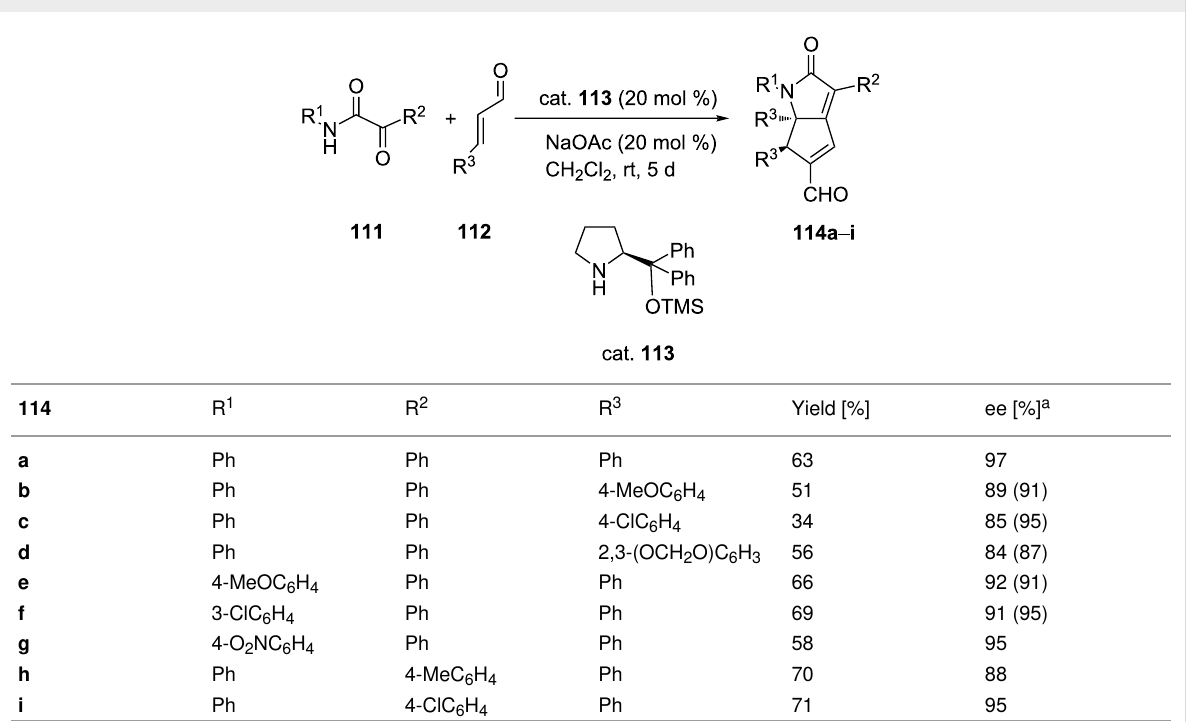
Table 26: Asymmetric aza-Michael organocatalytic quadruple cascade